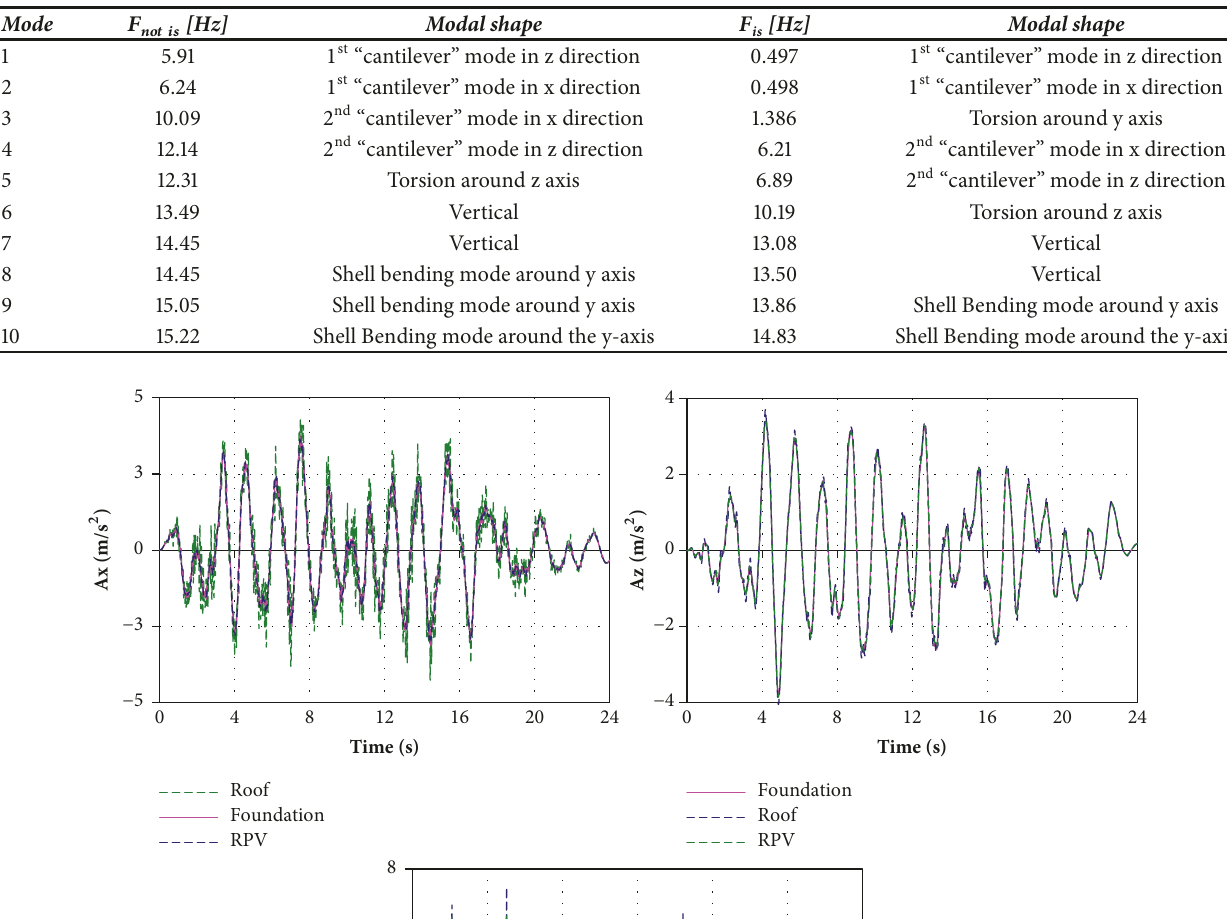
Table 2: Frequency and eigenmode.